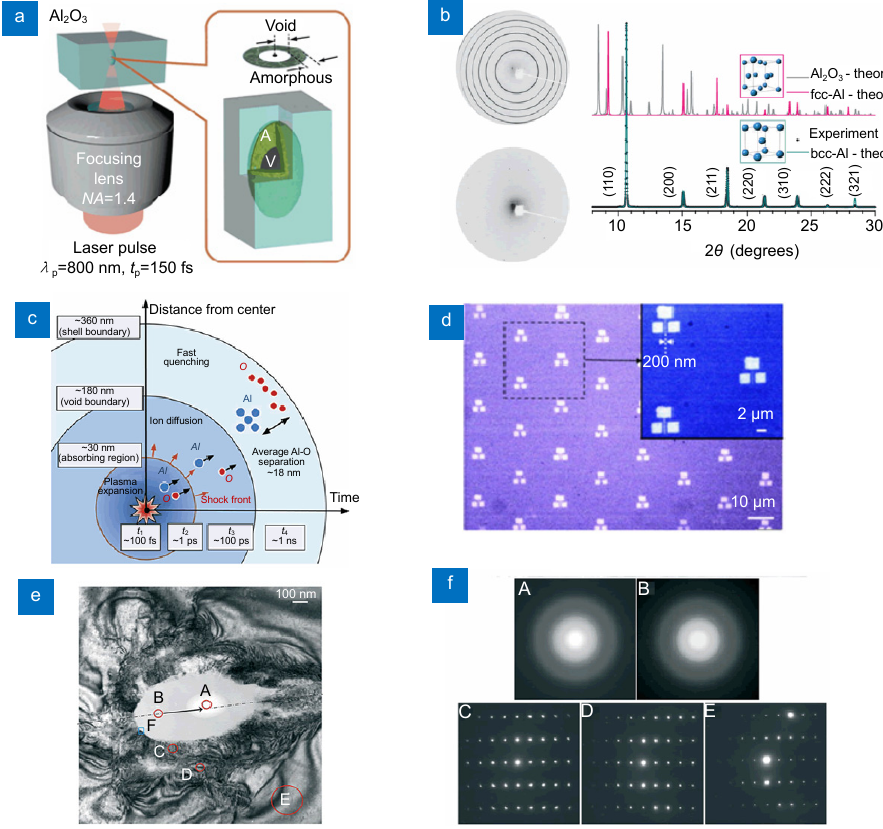
Fig. 2 | Laser induced phase change. ( a ) Schematic diagram of the fabrication of phase change in sapphire by femtosecond laser. ( b ) Micro- X-ray diffraction measurement for evidence on the formation of bcc-Al. ( c ) Schematic of phase transformations in laser modified sapphire. ( d ) Laser induced phase change in GST films for fabrication of field emission transistor. ( e ) TEM image and ( f ) electron diffraction patterns of laser induced crystalline-to-amorphous transition in sapphire. Figure reproduced from (a–c) ref. 54 , Springer Nature; (d) ref. 56 , AIP Publishing; (e, f) ref. 57 , WILEY-VCH Verlag GmbH & Co. KGaA,